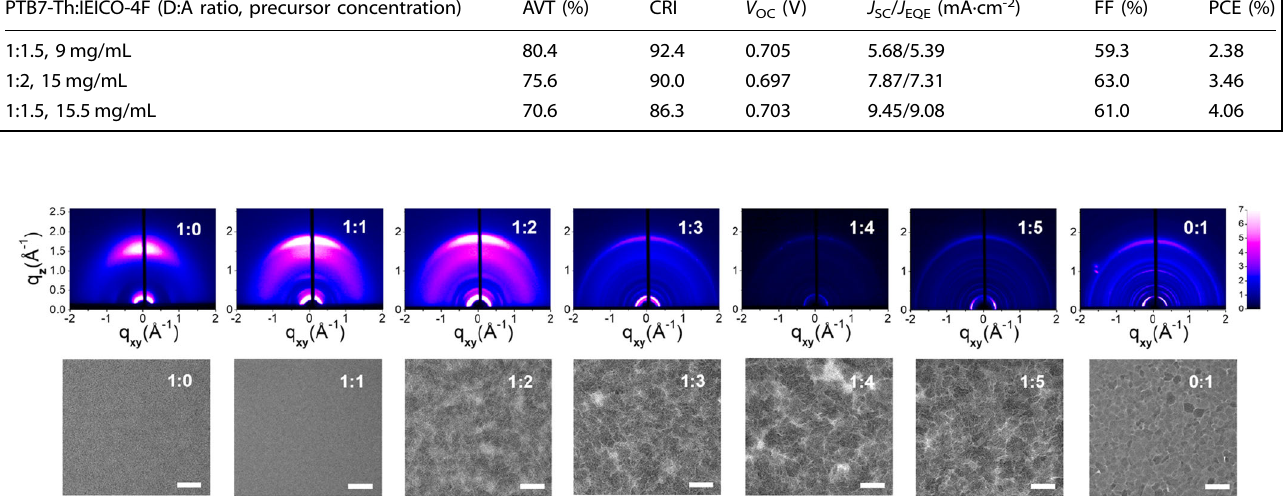
Table 2. Summarization of optical and photovoltaic parameters in TPVs with the AVT exceeding 70%. PTB7-Th:IEICO-4F (D:A ratio, precursor concentration)